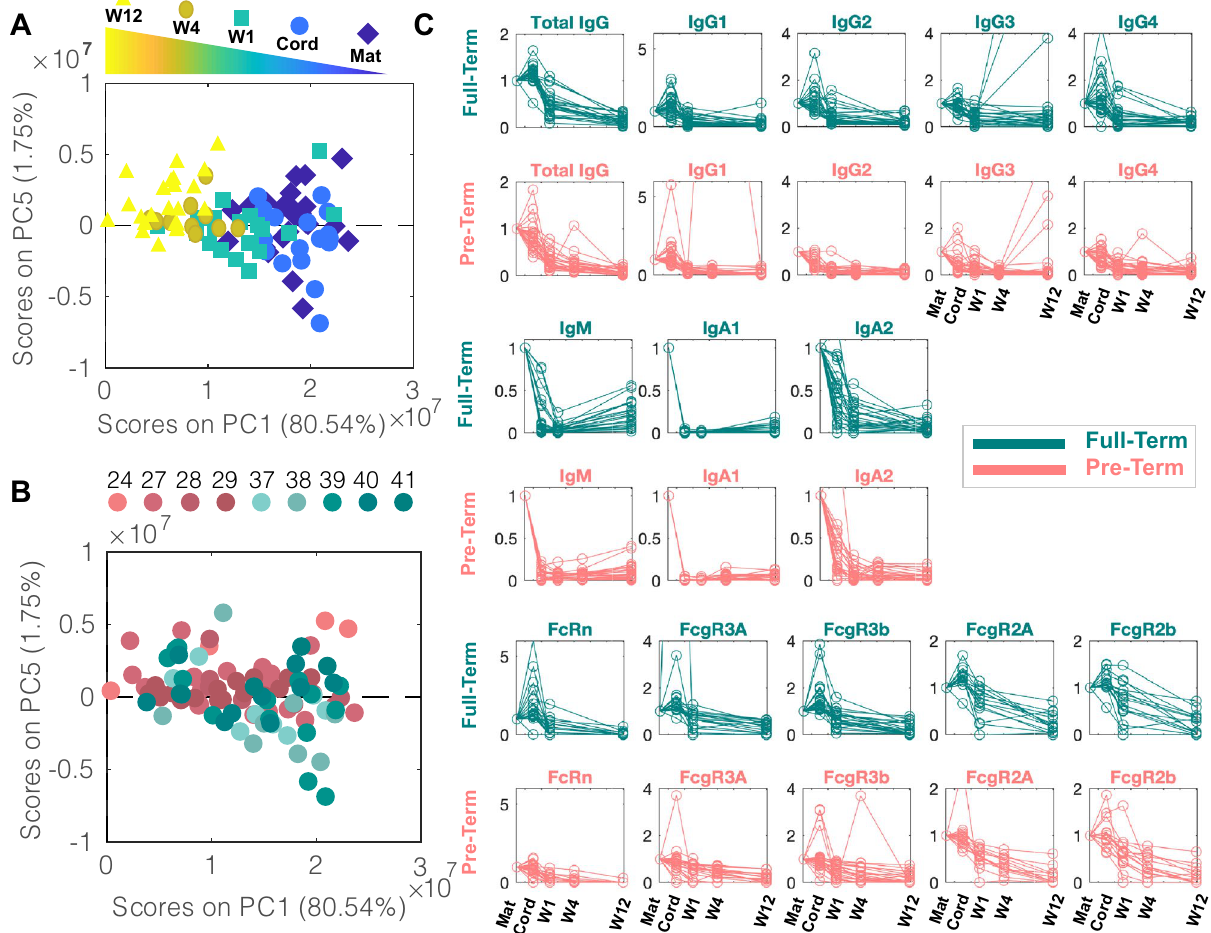
Figure 2. Convergence of antibody profiles over time. ( A , B ) Principal Component Analysis (PCA) was performed to reduce the dimensions of data from 323 to 5 dimensions to visualize the major axes of variation across the whole dataset. Each dot represents a sample. ( A ) 80% of the variance was captured by PC1, capturing the major variance in the data, picking up the evolution of the humoral profiles over time. The dot color represents the sample origin (maternal, cord, and time after birth). ( B ) In contrast to PC1, PC5 captures differences in antibody profiles across the PT and FT infants, where the dot color depicts the gestational group of the sample. ( C ) Each trendline represents the median of each antigen-specific measurement. These were normalized to the median of the maternal level of that antigen-specific measurement such that all trendlines start at a normalized value of 1. These were calculated separately for PT (pink) and FT (green) infants. One trendline is included per antigen per graph. Median tetanaus-, diphtheria-, and pertussis-specific (tdap) IgG3 peak at W12 for both pre-term and FT children, consistent with the Tdap administration to children between 6 and 8 weeks in